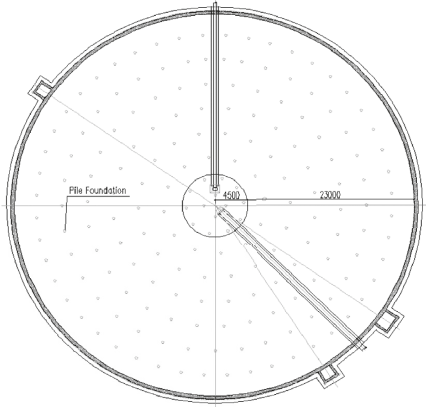
Figure 2: Typical layout for SST.